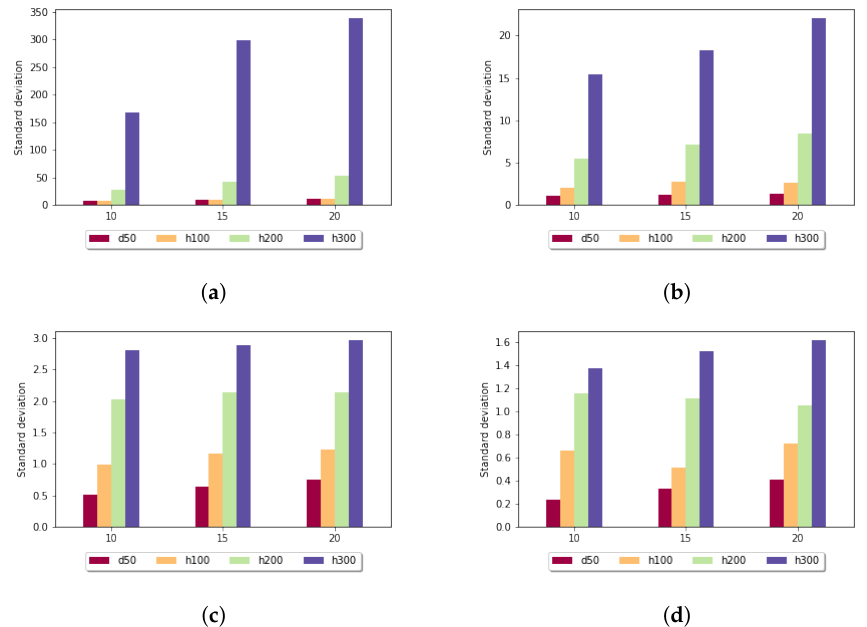
Figure 5. Standard deviation (y axis) depending on the size of the sample set (x axis) and length of the k-mers in the case of fixed gap penalty: ( a ) k = 5; ( b ) k = 7; ( c ) k = 10; and ( d ) k = 15.